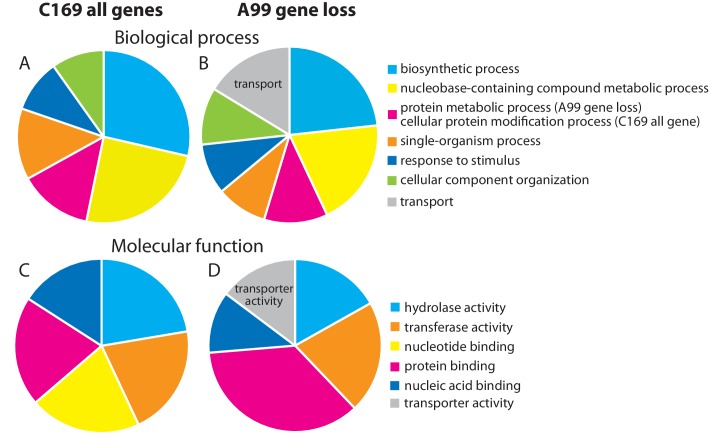
Genes missing in the genome of Chlorella A99.Functional categorization of genes present in Coccomyxa subellipsoidea C169 (A, C) and genes missing in Chlorella A99 (B, D) by GO terms using Bast2GO. Multilevel pie charts show enrichment of GO’ Biological Process’ terms (A, B) and GO ‘Molecular Function’ terms (C, D) on the lowest level, which cover at least 10% of the total amount of annotated sequences.10.7554/eLife.35122.026Figure 5—source data 1.Functional categorization of genes present in Coccomyxa subellipsoidea C169 (C169_all) and genes missing in Chlorella A99 (A99 gene loss) by GO terms’ Biological Process’ terms and ‘Molecular Function’ on the lowest level, which cover at least 10% of the total amount of annotated sequences.